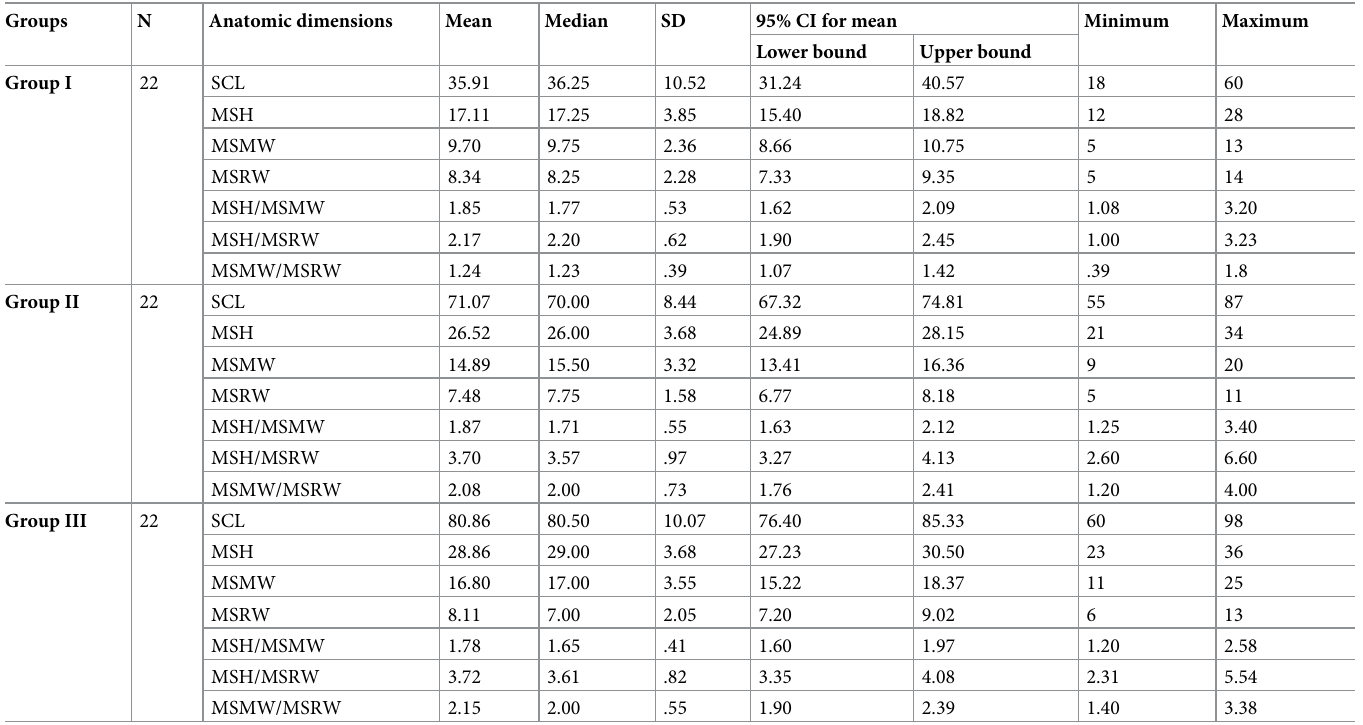
Table 2. Sigmoid colon anatomic dimensions